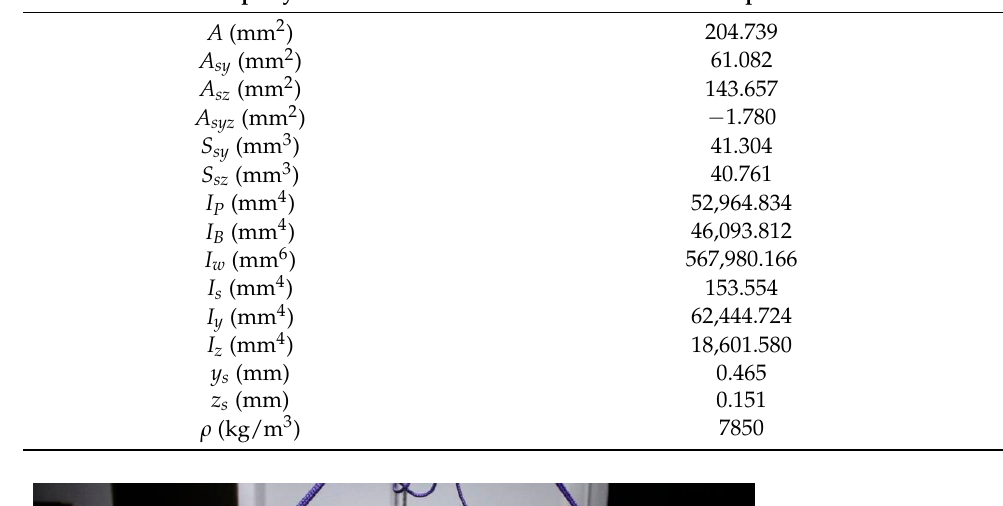
Figure 8. Beam cross-section used in the test. Table 8. Property details of the beam considered in the experimental model. Property